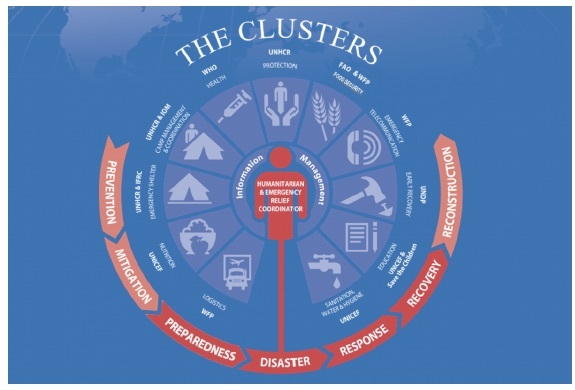
Photo credit: Office for the Coordination of Humanitarian Affairs49